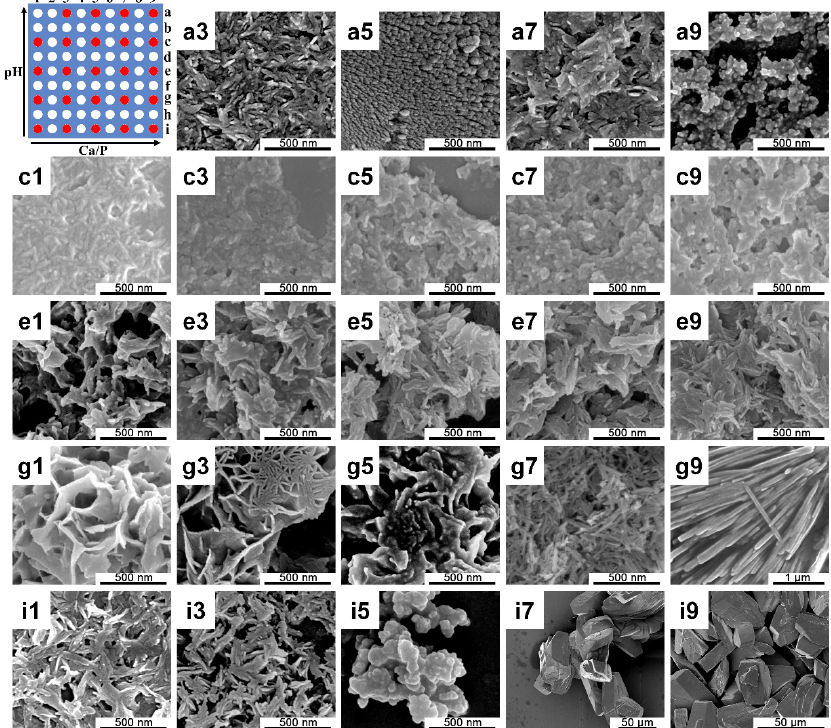
Figure 5. A schematic of the microreactors array and SEM images of CaP structures observed in the screening platform with a two-dimensional gradient for the pH values and the Ca/P ratio, separately. From rows i to a (bottom to top), the pH values increased from 7 to 13; from columns 1 to 9 (left to right), the Ca/P ratio increased from 0.5 to 2.0. The red spots correspond to the positions of the precipitated samples of SEM acquisition.